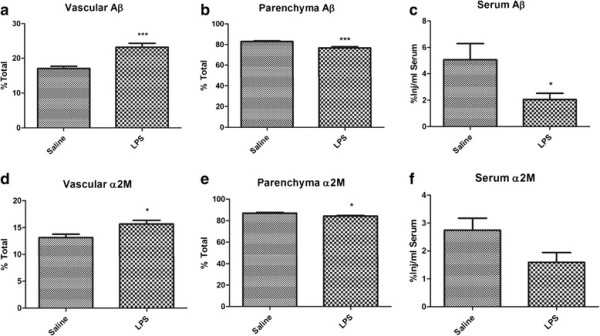
Distribution of ICV-injected murine125I-Aβ1-42(a–c) or activated 125I-a2M (d,–f) in the vasculature (a,d), parenchyma (b,e), and serum (c,f) after treatment with LPS. Data analyzed by two-tailed t-test, n = 10–11 per group, *P < 0.05; ***P < 0.001.